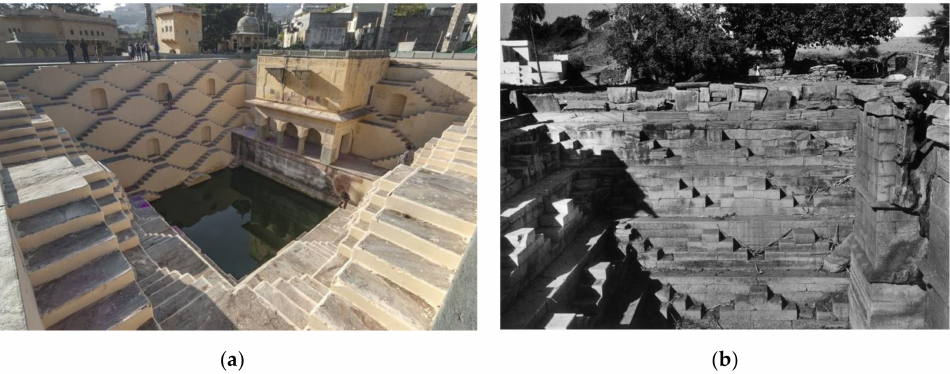
Figure 1. Photographs of the two stepped ponds used as exemplars in this paper: ( a ) Panna Meena ka Kund (also known as Panna Mia Kund and Panna Mian Kund); ( b ) Lahan Vav (also known as Lahini Vapi and Vasantgadh Stepped Pond). Source: American Institute of Indian Studies [25], used with